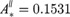
Steady state behavior of the PTGs and DTGs as functions of the parameter A upon h = 6, a3
= 14.5, a7
= 14.Abscissas of the turning points of w1 and w2 curves with values A*||=0.1531 and A*|=0.2653 determine the limits of the bistable behavior (marked by asterisks). As the parameter A is boosted beyond A*|=0.2653, the core network switches to the pluripotent state, while when the external signal is dropped below A*||=0.1531, the system switches to differentiation state.